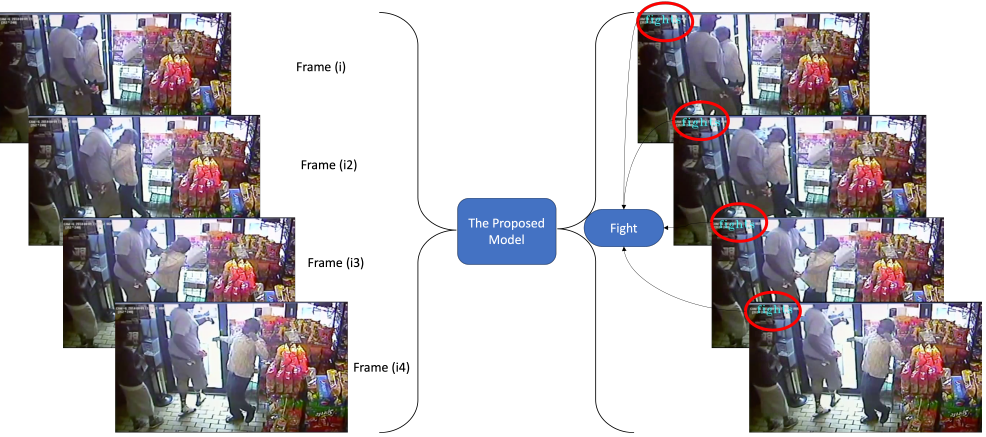
Figure 6. Visual output results of the proposed model over testing data from